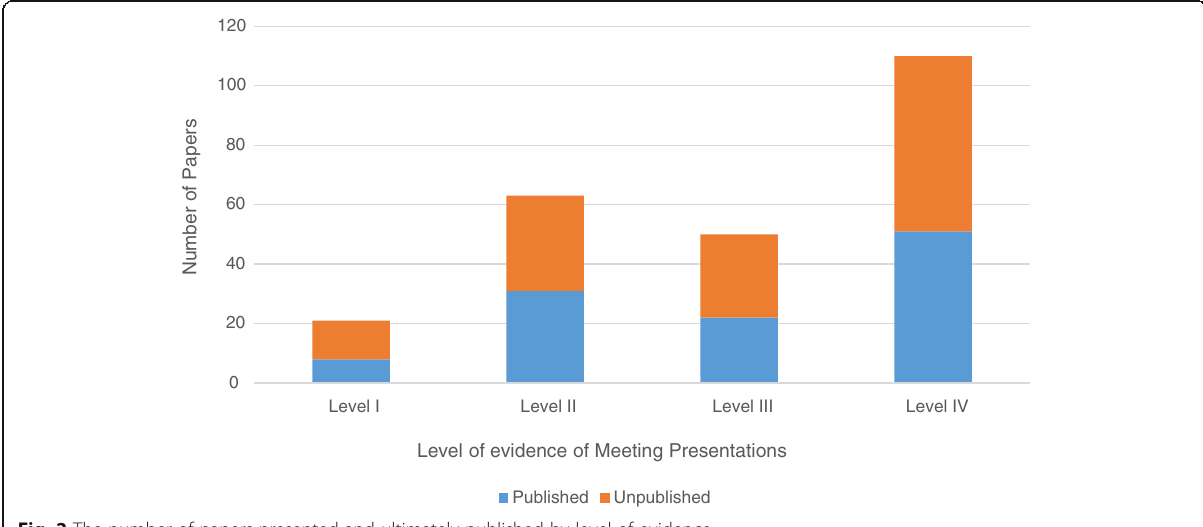
Fig. 2 The number of papers presented and ultimately published by level of evidence